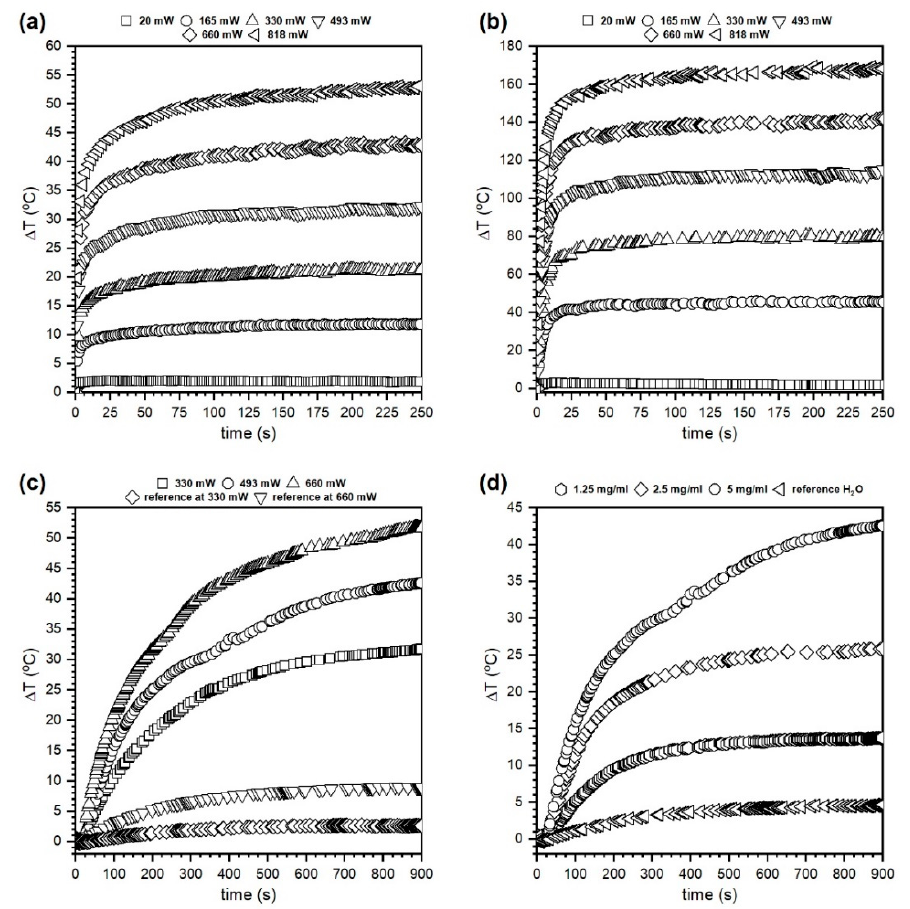
Figure 6. Heat induction of the PRHD and PRHD@MnFe 2 O 4 hybrids under stimulation of 808 nm NIR laser for dry powders (upper panel) and colloidal suspensions (bottom panel). The ( a , b ) plots represent the behavior of PRHD and PRHD@MnFe 2 O 4 , ( c ) shows the power dependence of PRHD@MnFe 2 O 4 dispersion (5 mg / mL), and ( d ) concentration dependence of PRHD@MnFe 2 O 4 suspensions (LOD 0.31 W / cm 2 ), respectively. Reference measurements done on pure water ( c )—for 0.21 and 0.42 W / cm 2 and ( d ) 0.31 W / cm 2 .